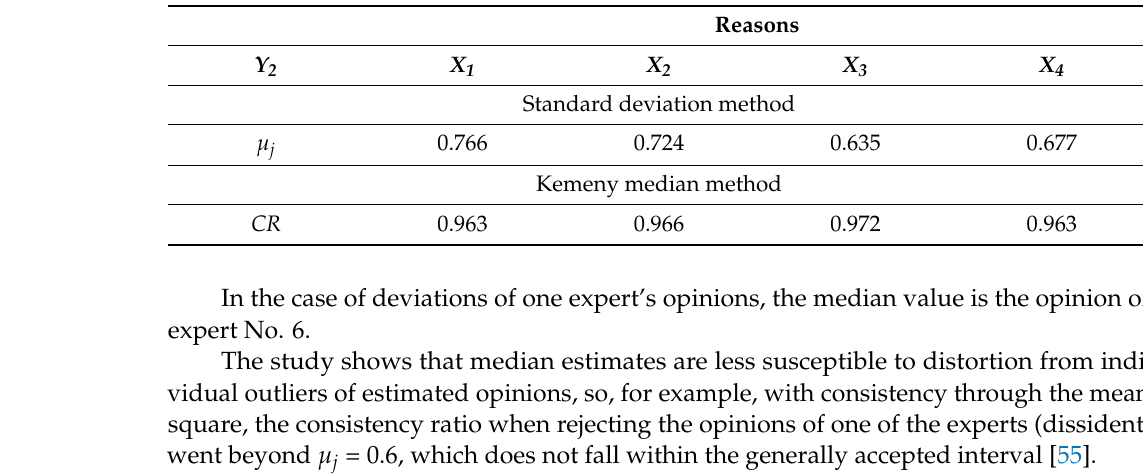
Table 7. Consistency of expert opinions with deviations of one expert’s